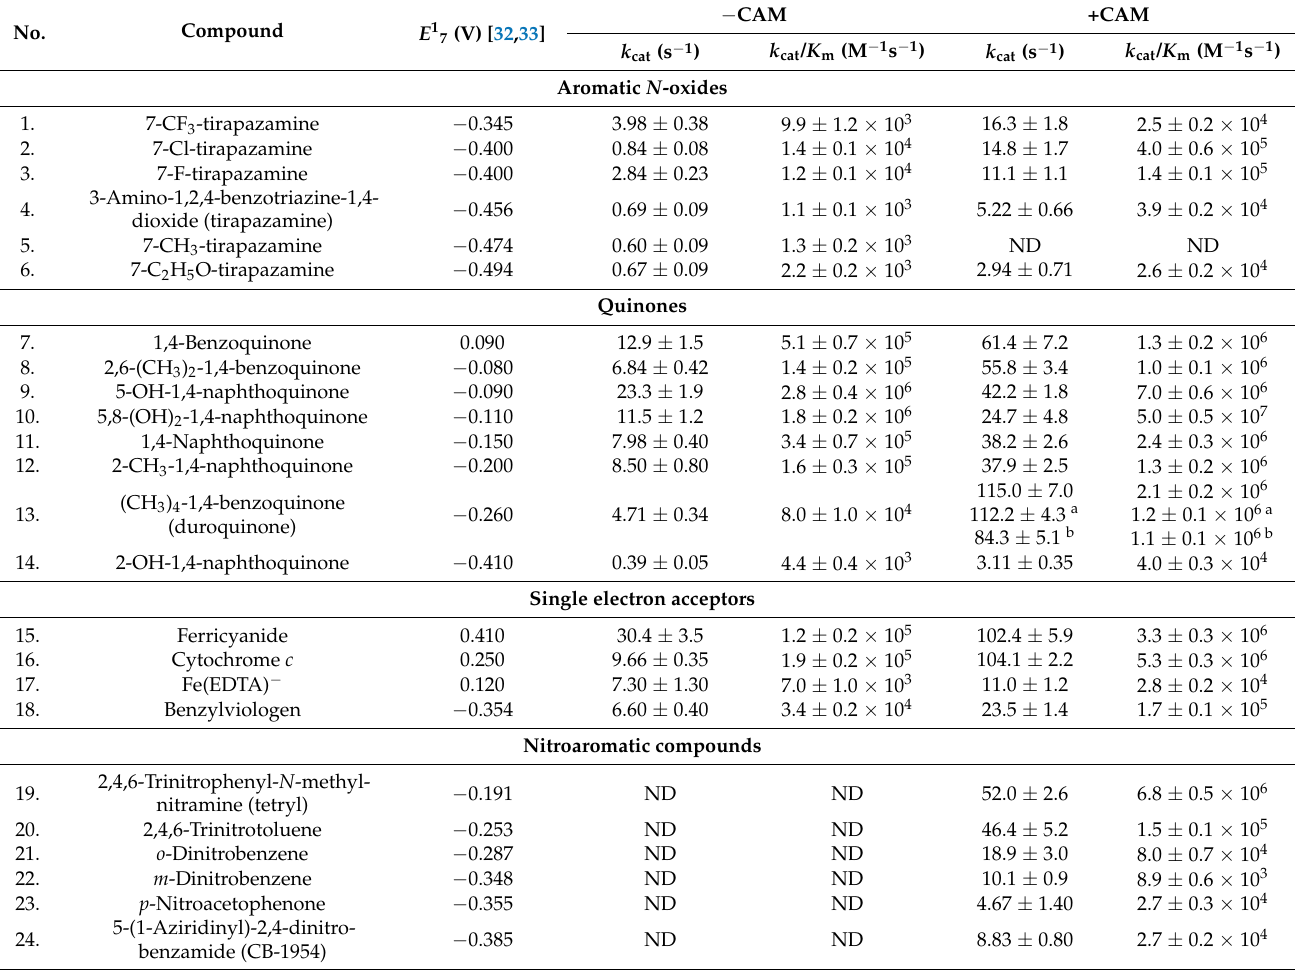
Table 1. Steady-state rate constants of the reduction of nonphysiological electron acceptors by NADPH catalyzed by nNOS. [NADPH] = 50 µ M, 0.1 M Tris/HCl + 1 mM EDTA + 100 mM